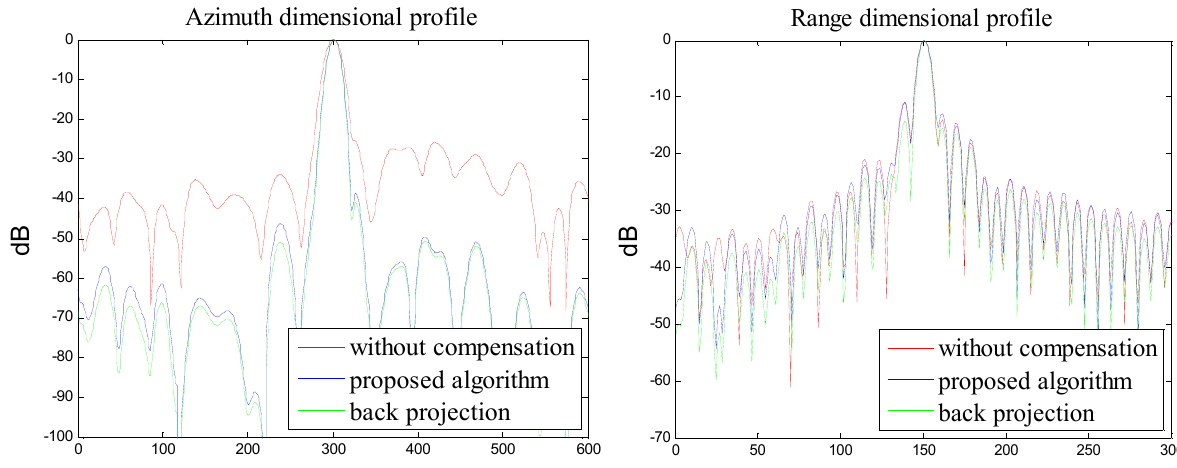
Figure 10. The profile response of the trihedral angle reflector labeled 1.